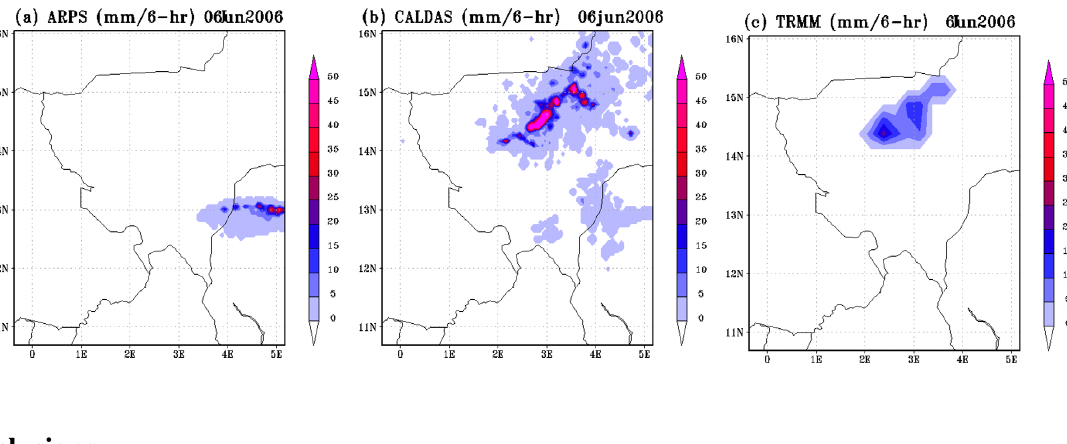
Figure 8. Comparison of 6 hours (from 03UTC to 09UTC) accumulated rainfall (mm) obtained from ( a ) ARPS; ( b ) CALDAS; and ( c ) TRMM,